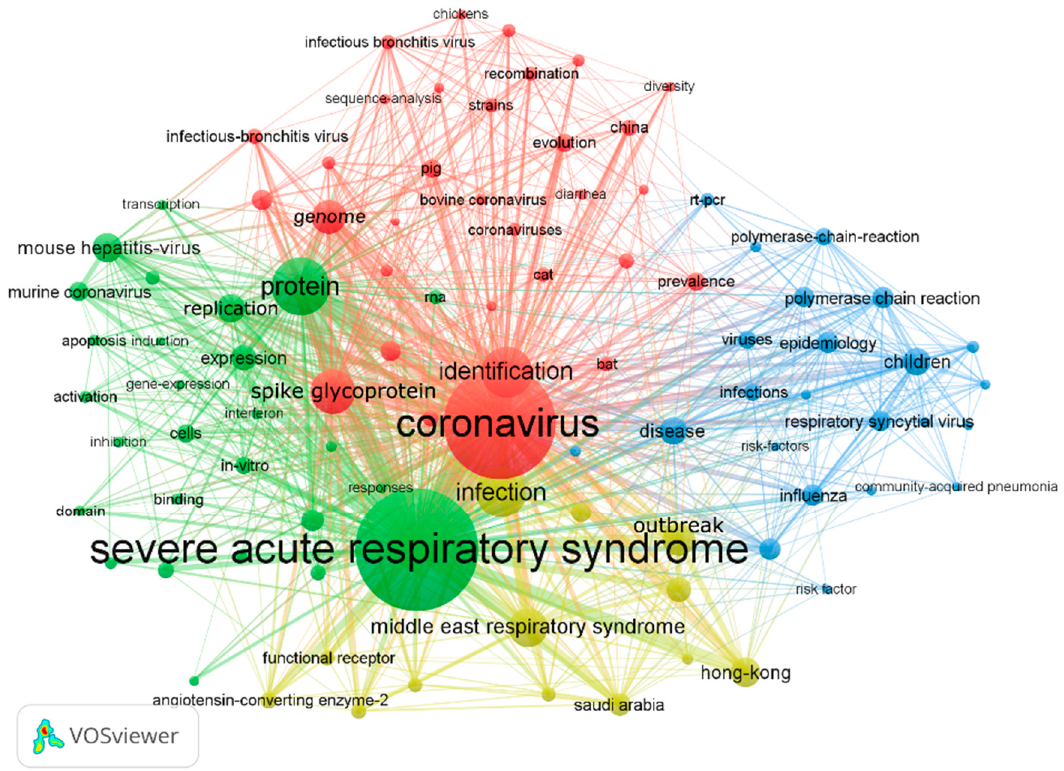
Figure 8. Co-occurrence network of keywords.